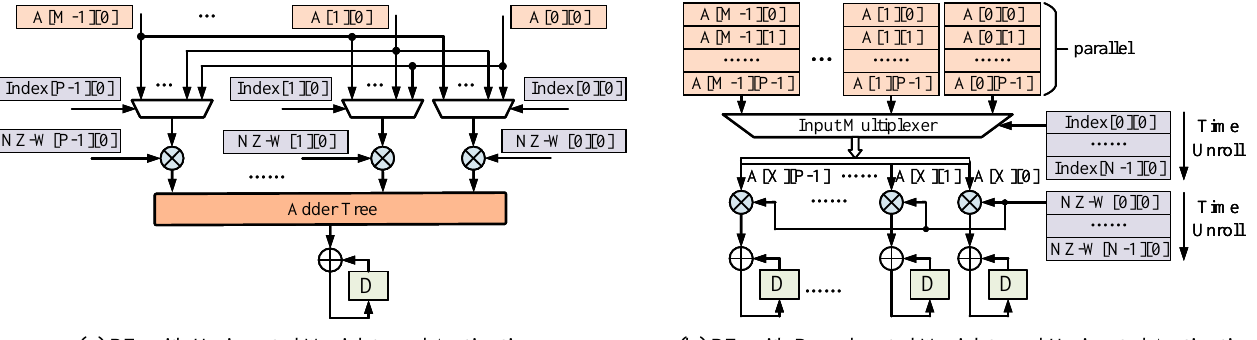
Figure 2. Processing Element (PE) architectures for input-channel-wise N : M sparse pattern. A[I][F] represents the F-th activation data in the I-th input feature plane. NZ-W[O][I] denotes the weights of the I-th input channel of the O-th output channel. The coordinates of Index[O][I] have the same meaning as NZ-W[O][I]. Symbols with ‘+’ and ‘x’ operators in circles denote adders and multipliers, respectively. These symbols have the same meaning in the rest of the